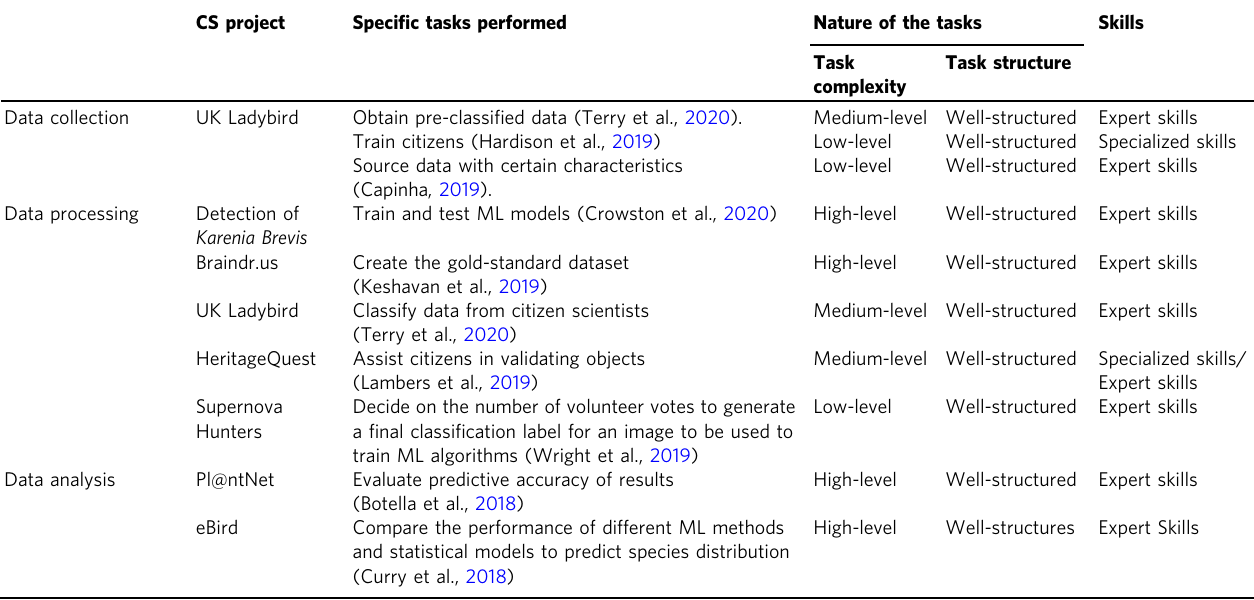
Table 6 Tasks performed by experts and skills needed across the activities — examples from the